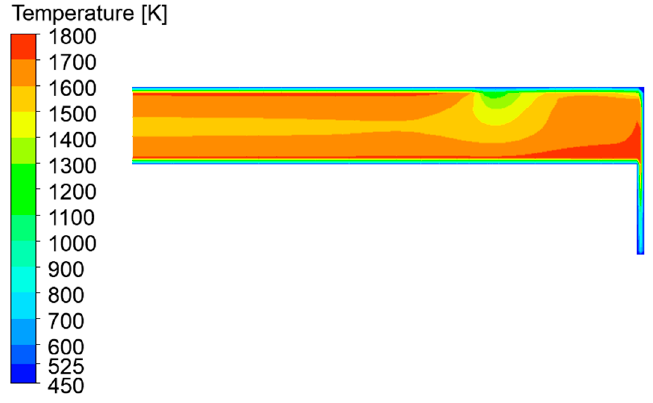
Figure 16. Temperature distribution at 8 CAD ATDC without swirl.